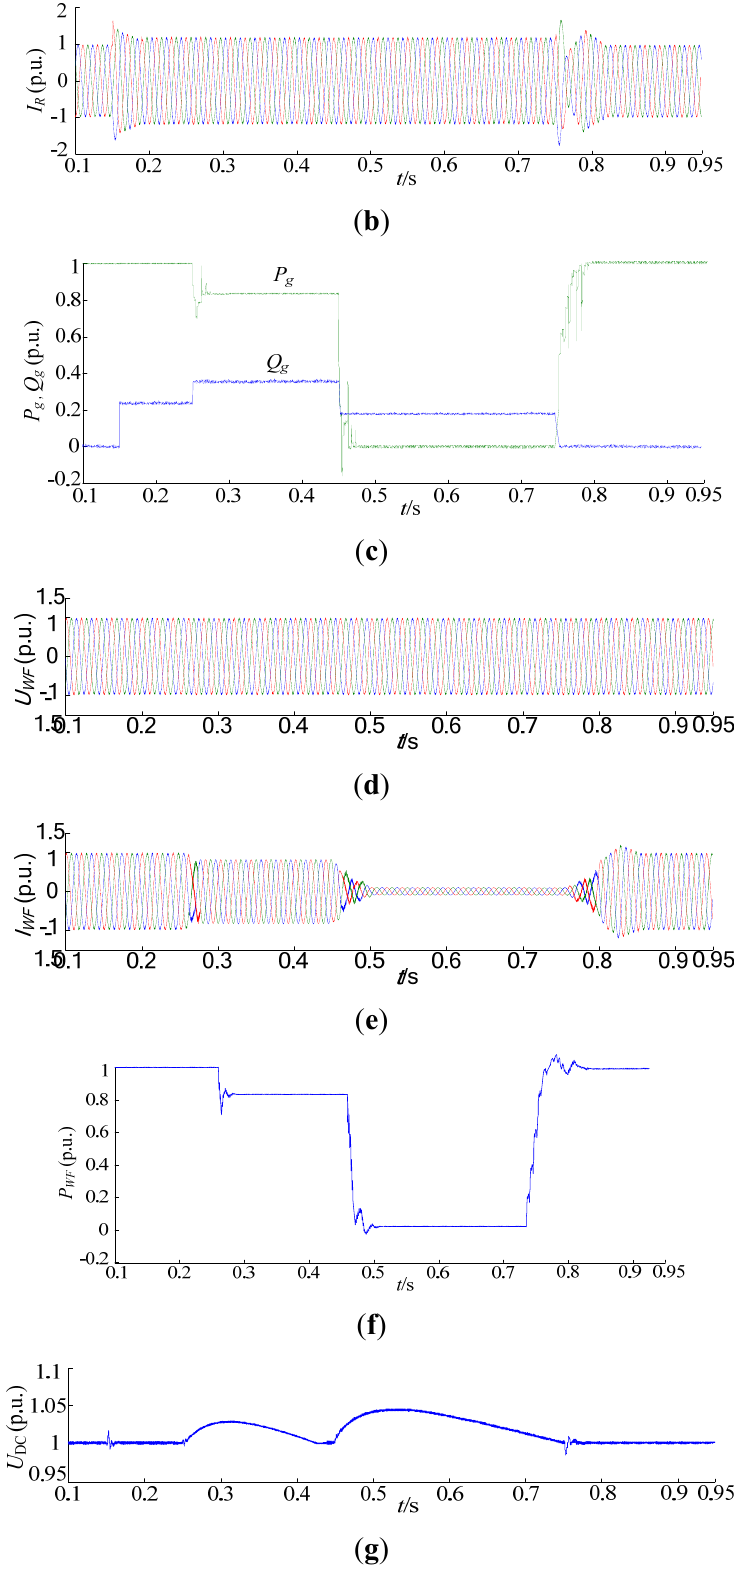
Figure 16. The simulation results of the LVRT coordination control for the VSC-HVDC-based wind power system. ( a ) Grid voltage; ( b ) REC current; ( c ) REC active power and reactive power; ( d ) Wind farm export voltage; ( e ) Wind farm export current; ( f ) GSC active power output; ( g ) DC line voltage of